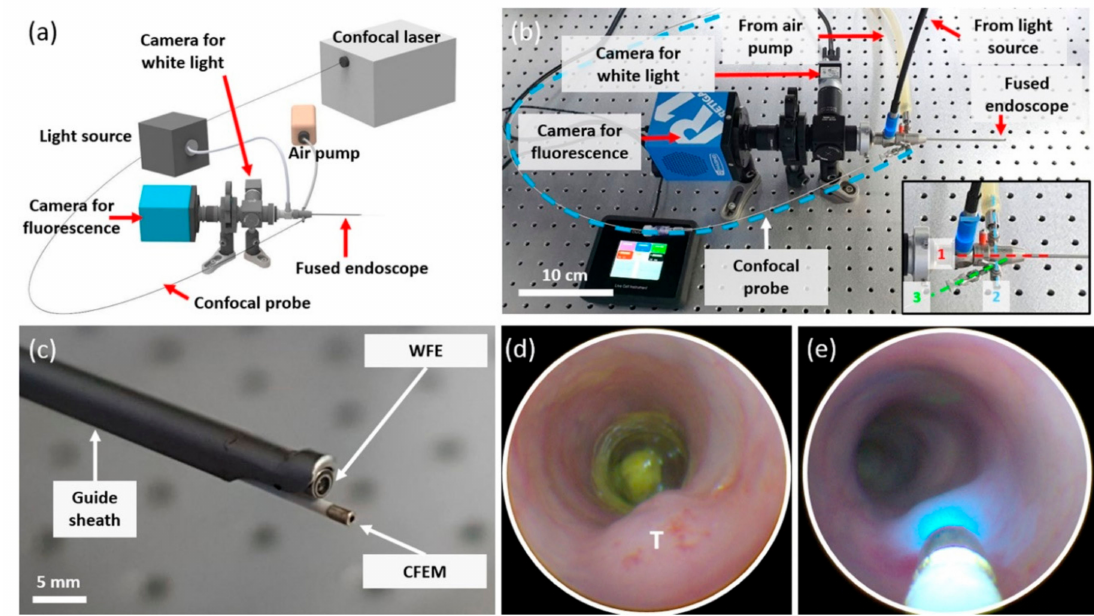
Figure 1. Dual-scale fluorescence endoscopy (DSFE) system. ( a ) Scheme of major component of the DSFE system. ( b ) Corresponding photography of the DSFE system. Inset photography shows three channels of the guiding sheath. ( c ) Magnified endoscopy tip of the fused DSFE probe. The tip diameter of the wide-field fluorescence endoscope (WFE) and confocal fluorescence endomicroscopy (CFEM) probes are 1.9 mm and 0.94 mm, respectively. ( d , e ) In vivo white-light WFE endoscopic images of inside the mouse colon with orthotropic mouse colon tumor (T) and the laser emitting from the CFEM probe into the tumoral